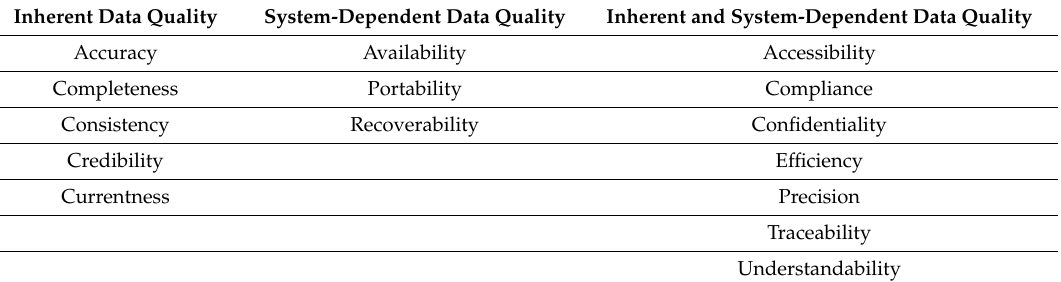
Table 2. ISO data literacy categories based on